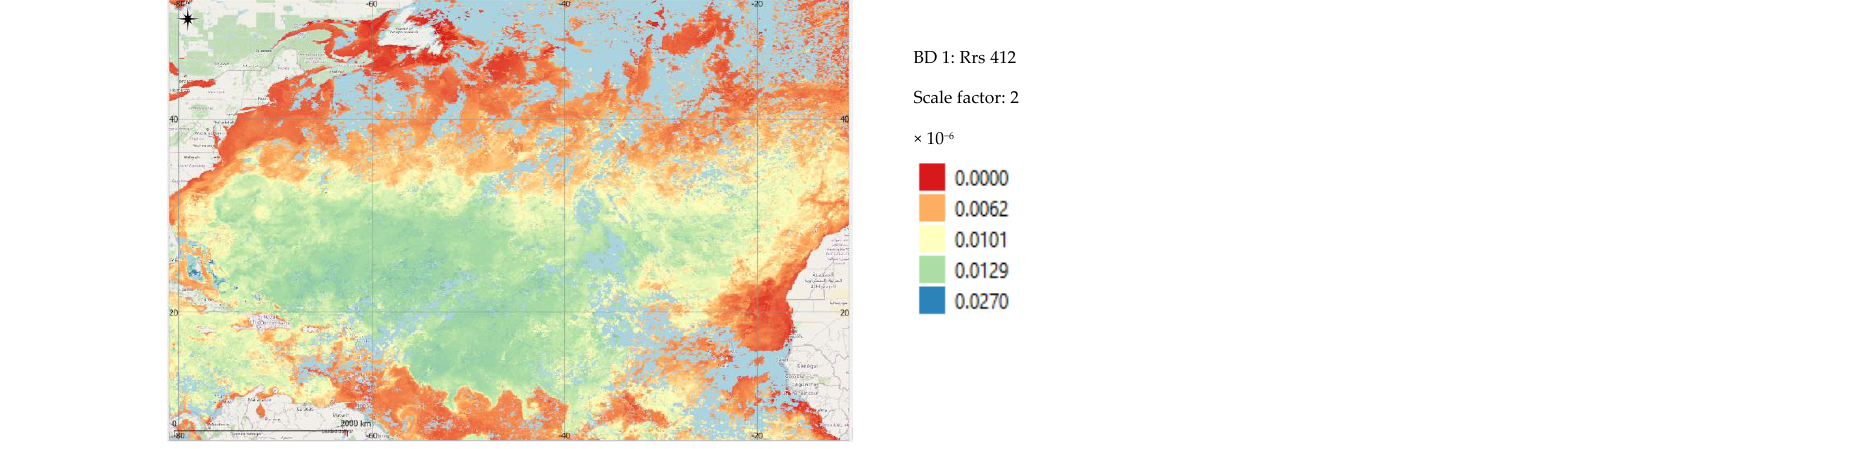
Figure 3. Multi-source, composite physico-chemical and biological data covering the period of Spring 2016, from which co-located and co-temporal values at points shown in Figure 1 were extracted to train the BPN algorithm. The sources and codes of these multi-source, independent datasets are listed in Table 2.